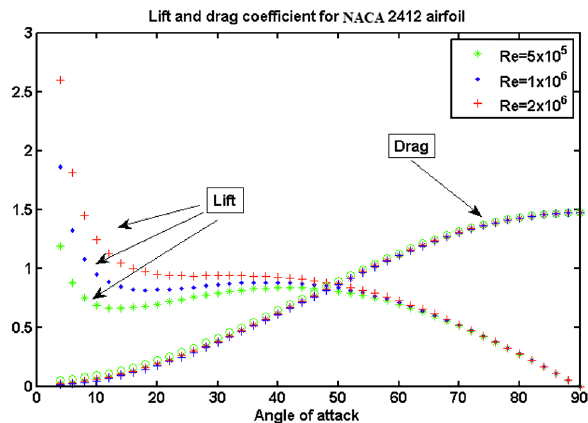
Figure 3. Lift and drag coef fi cient variation with Angle of Attack ( i